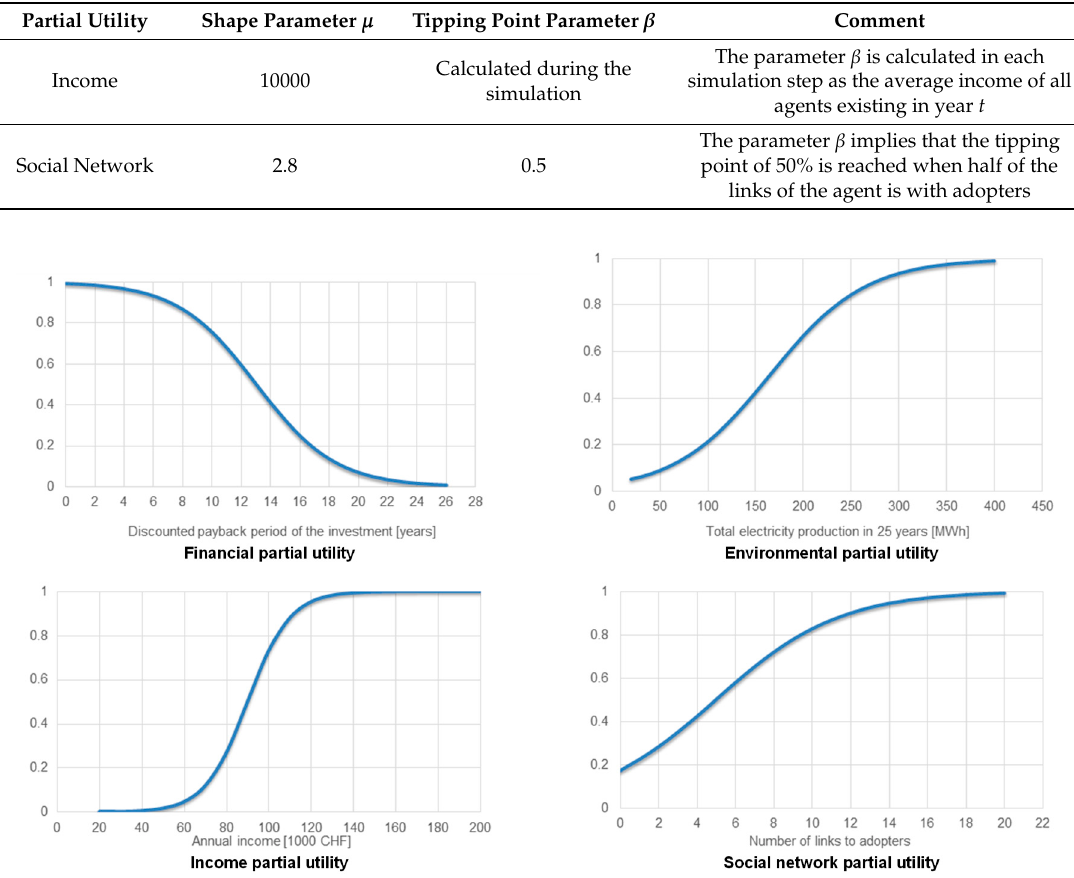
Figure A4. The four partial utilities influencing the investment decision of an agent. Figure B 1. The four partial utilities influencing the investment decision of an agent.